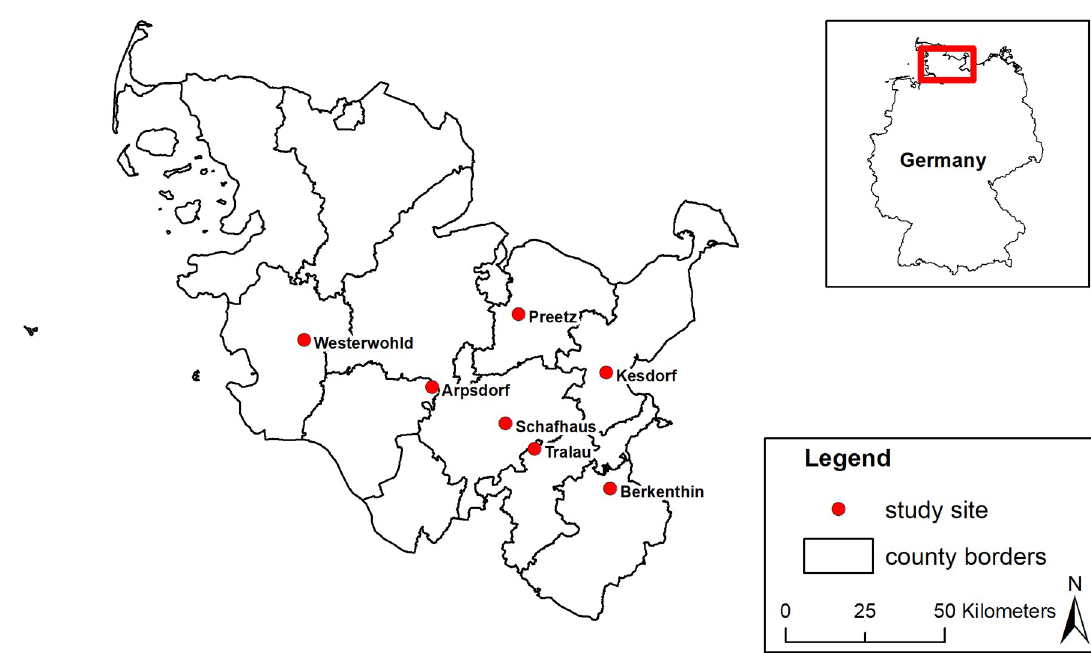
Fig 1. Study area in Schleswig-Holstein, Northern